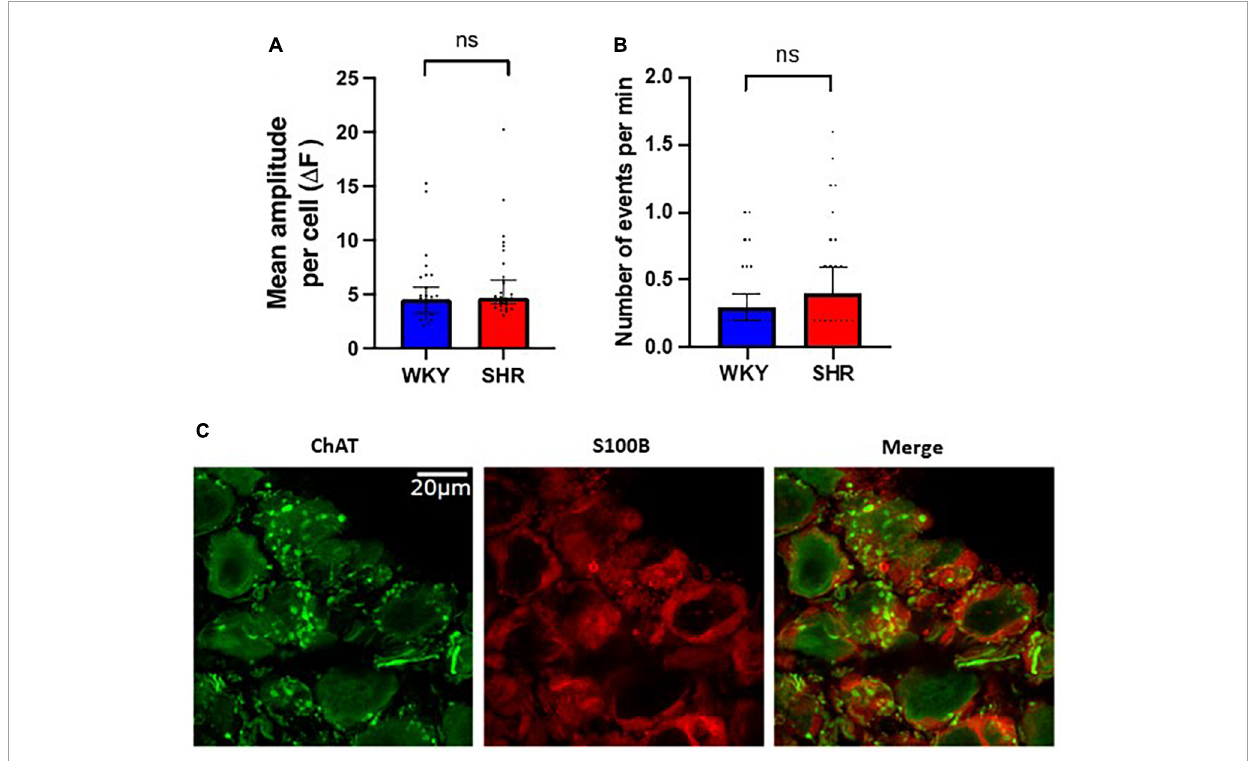
FIGURE3 Spontaneous Ca 2 + events in glial cells surrounding ganglionated plexi (GP) neurons. Fluorescence responses of putative glial cells in Wistar Kyoto (WKY) (blue) and spontaneously hypertensive rat (SHR) (red) GPs, showing (A) the mean amplitude response per cell (median ± 95% CI; Mann-Whitney test p > 0.05) and (B) the frequency of responses (median ± 95% CI; Mann-Whitney test p > 0.05) (5 WKY, 19 cells; five SHR, 23 cells). (C) Immunohistochemistry images of rat GP neurons showing ChAT positive (green) neuronal cell bodies and fibers encases by S100B positive (red) glial